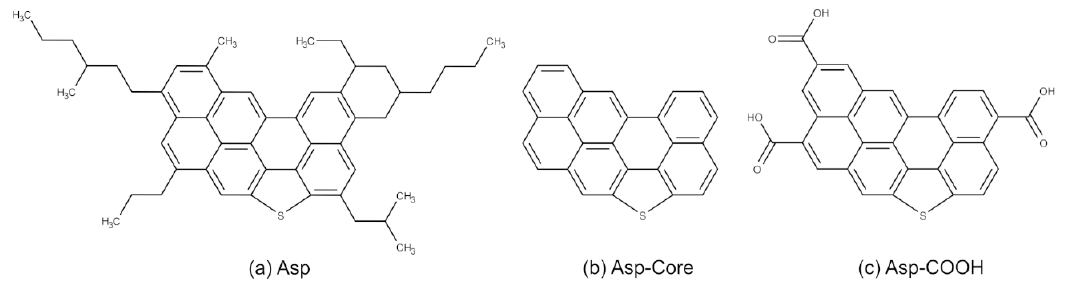
Figure 1. Chemical structures of the model asphaltene molecules with ( a ) aliphatic side groups proposed by Mullins [33], Li and Greenfield [34] (Asp), ( b ) aliphatic side groups cut-off (Asp-Core) [35] and ( c ) three carboxyl groups (Asp-COOH) [24].